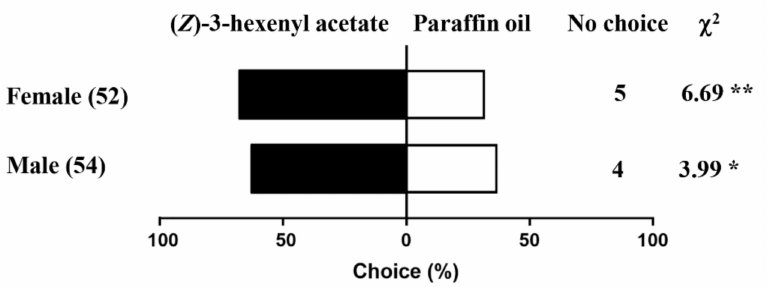
Figure 9. Behavioral responses of male and female Peridroma saucia to ( Z )-3-hexenyl acetate in a Y-tube olfactometer. If a parasitoid did not make a choice, it was removed and recorded as “no choice”. Numbers in brackets represent sample sizes ( chi -squared test, ** p < 0.01; * p < 0.05). Moths that made “no choice” were not included in the statistical